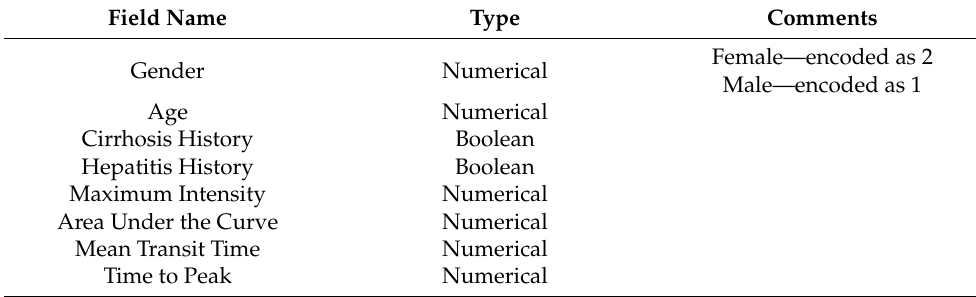
Table 4. Dataset fields used for training the feed-forward neural network model.